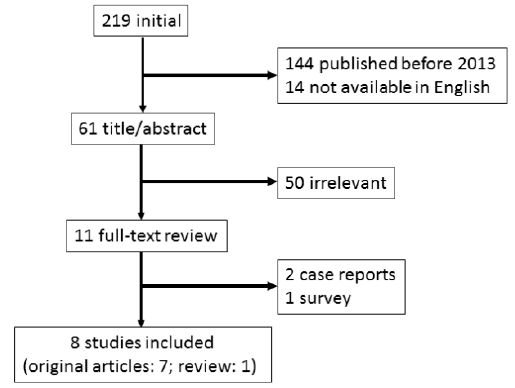
Figure 5. Study flow chart in palliative radiotherapy for bleeding gastric cancer.